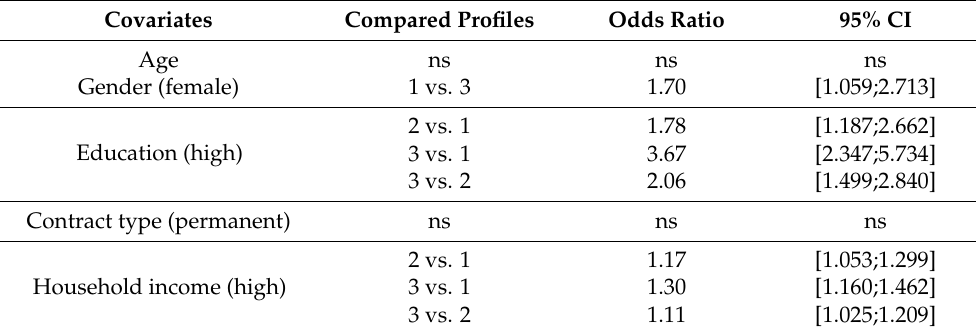
Table A3. Covariates of the latent profile membership at Time 2.